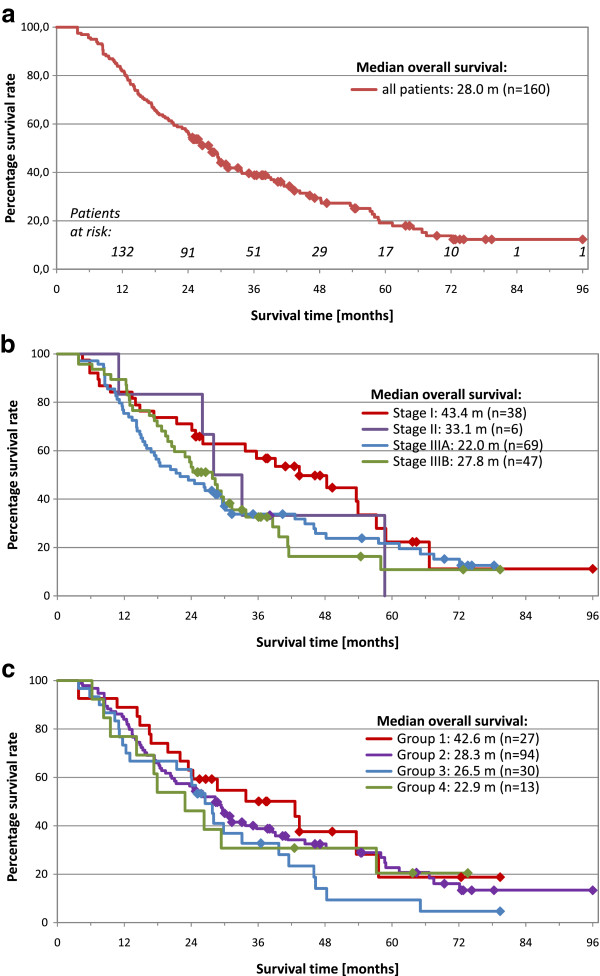
Overall survival. Kaplan-Maier plots for a) all patients; b) patients by tumor stage; c) patients by tumor size groups.